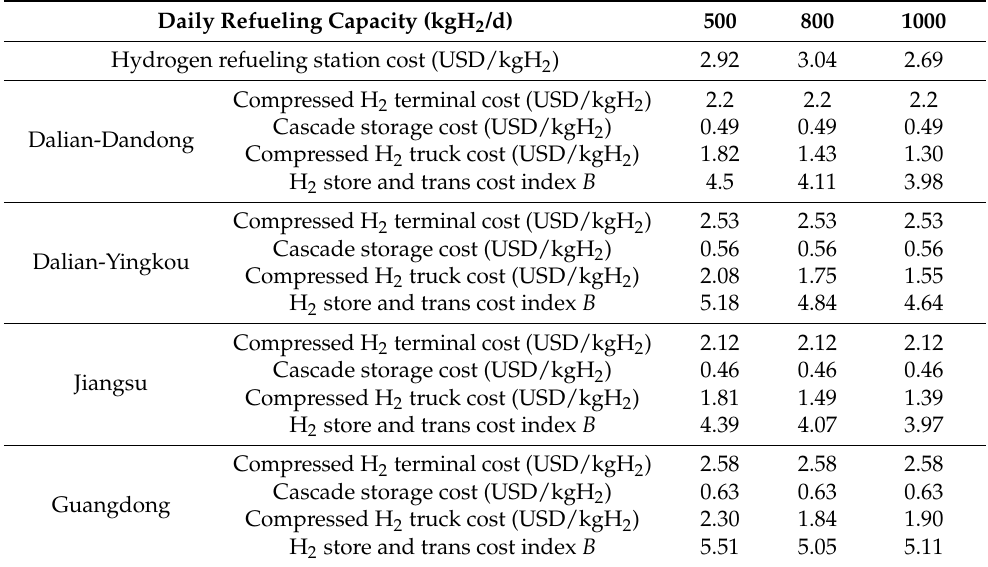
Table 9. The summary of calculation results.